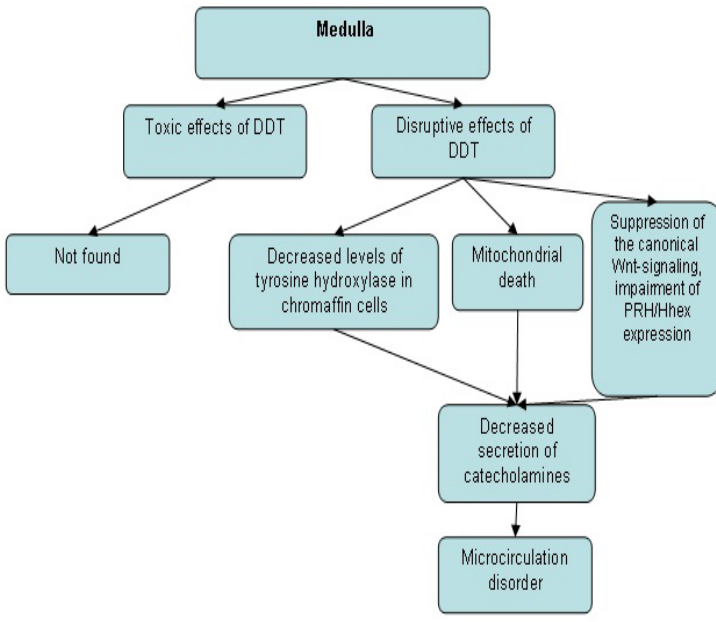
Figure 1. Changes in the morphogenesis and secretory activity of the adrenal medulla after exposure to toxic and disruptive doses of DDT.